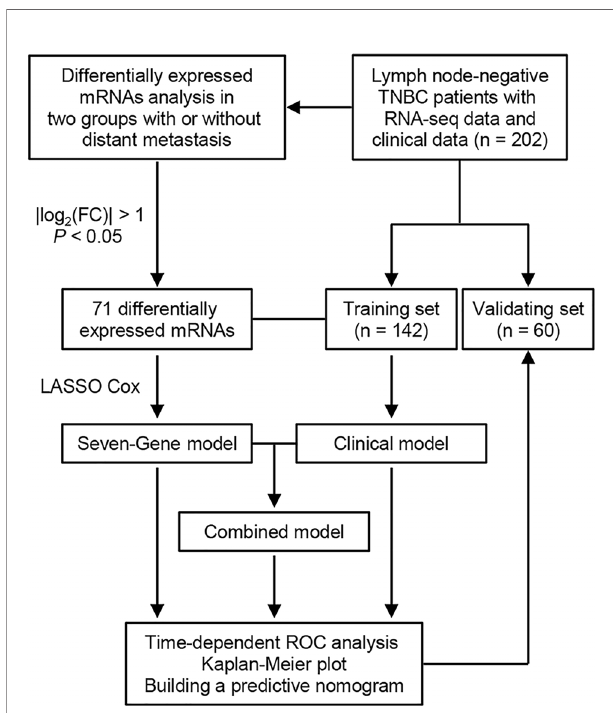
FIGURE 1 | Flowchart of study design. TNBC, triple-negative breast cancer; FC, fold change; LASSO, least absolute shrinkage and selection operator; ROC, receiver operating characteristic.